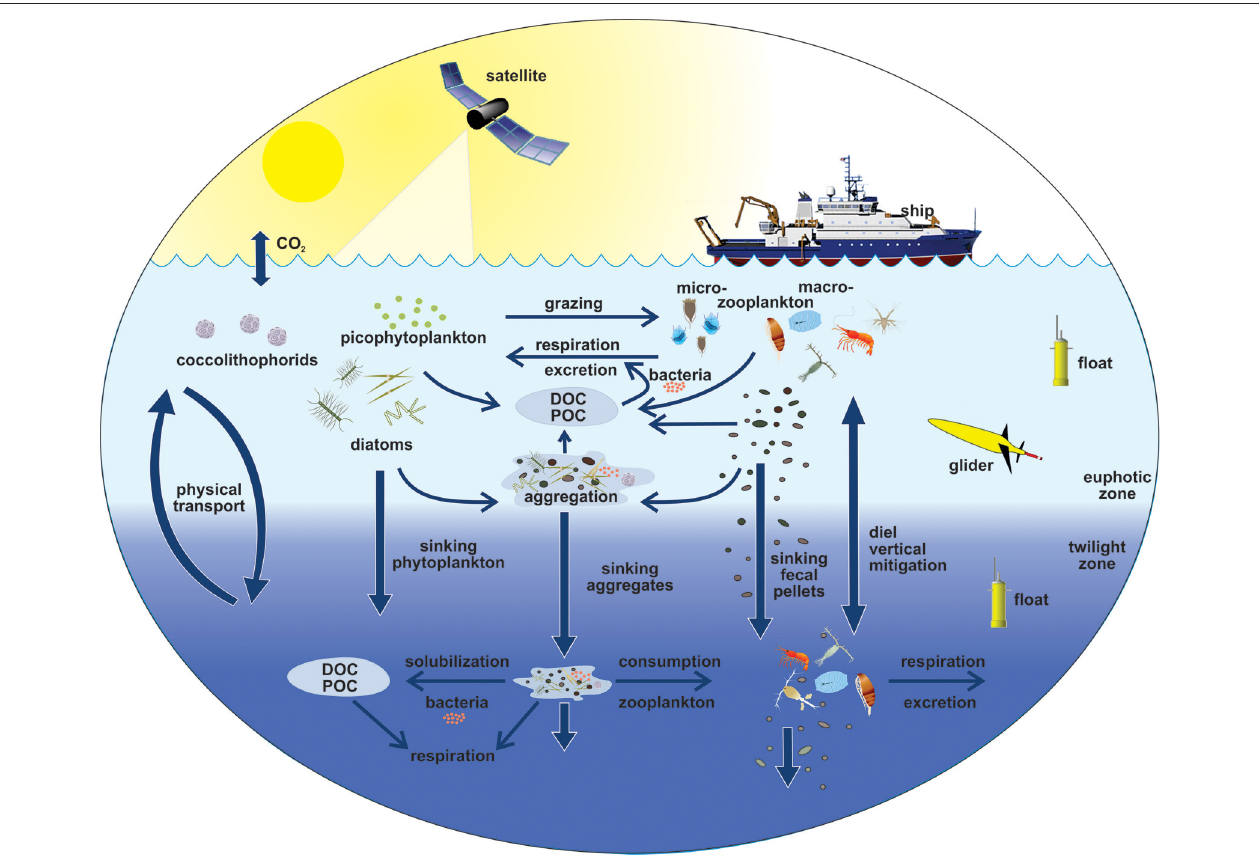
FIGURE 1 | The EXPORTS conceptual diagram illustrates the links among the ocean’s biological pump and pelagic food web and our ability to sample these components from ships, satellites, and autonomous vehicles. Light blue waters are the euphotic zone (EZ), while the darker blue waters represent the twilight zone (TZ). Figure is adapted from Steinberg (in prep.) and the U.S. Joint Global Ocean Flux Study (JGOFS)